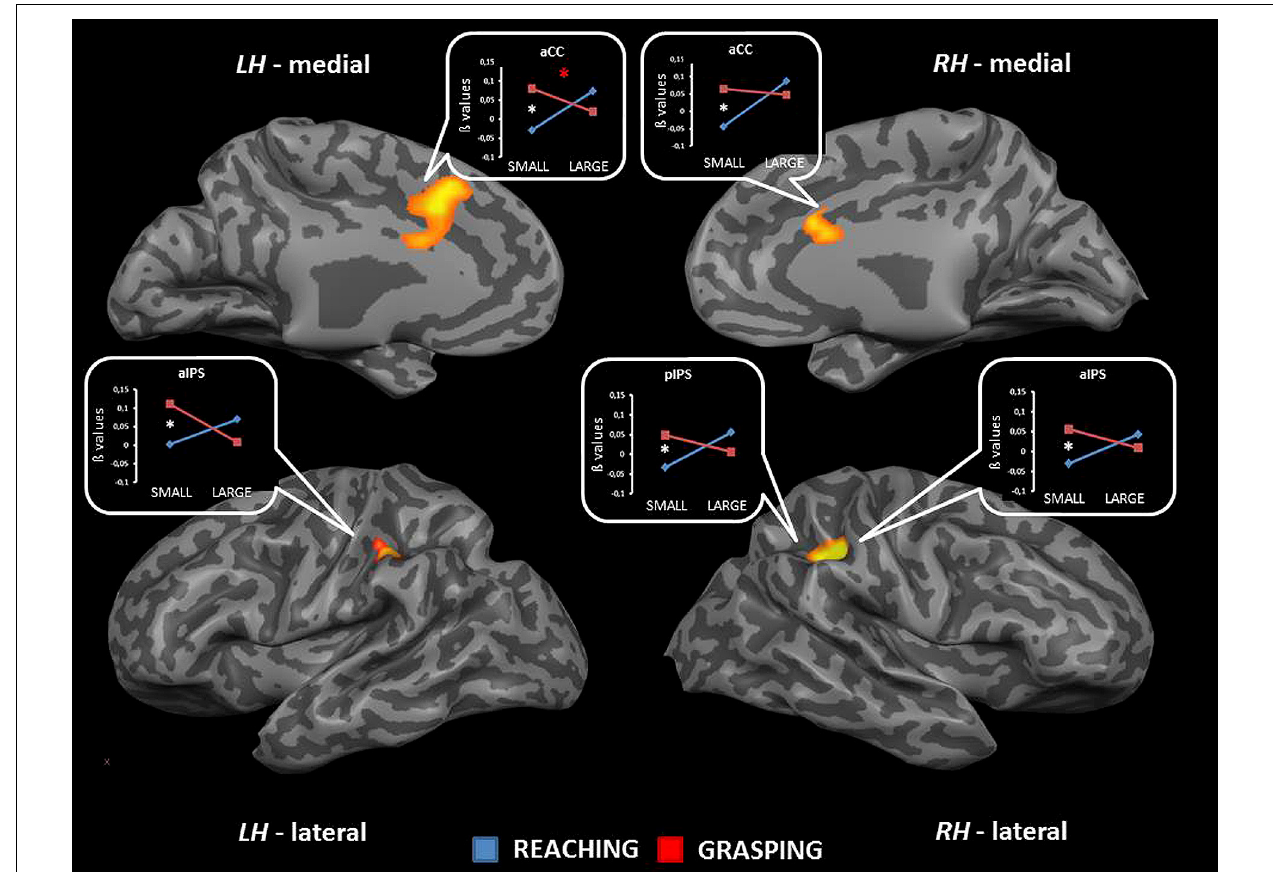
FIGURE 2 | Brain regions showing significant interaction effects between type of movement and stimulus dimension inTB 4. The p value is set to 0.001, uncorrected for multiple comparisons, cluster size k ≥ 13.White asterisks indicate significant effects for the contrast GS > RS; red asterisks